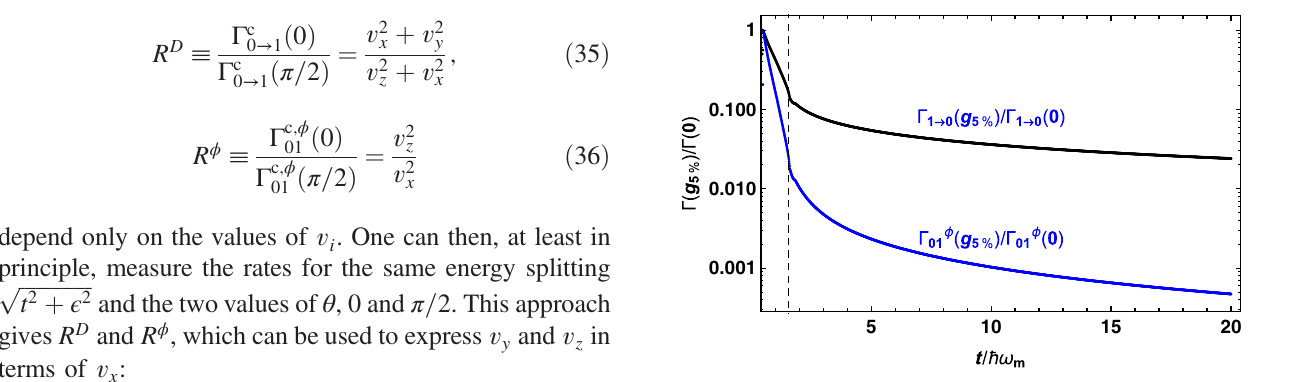
FIG. 9. Ratio of the decay rate Γ qb 1 → 0 ð g 5% Þ = Γ qb 1 → 0 ð g ¼ 0 Þ and pure decoherence rate Γ qb ; ϕ 10 ð g 5% Þ = Γ qb ; ϕ 10 ð g ¼ 0 Þ as a function of t= ℏ ω . We assume R D ¼ R ϕ ¼ 1 , and we neglect oscillator m damping ( γ ¼ 0 ). The vertical dashed line indicates the beginning of the region where the qubit becomes dominated by the two charge states, i.e., where t < 1 . 54 ℏ ω (cf. also inset of Fig. m